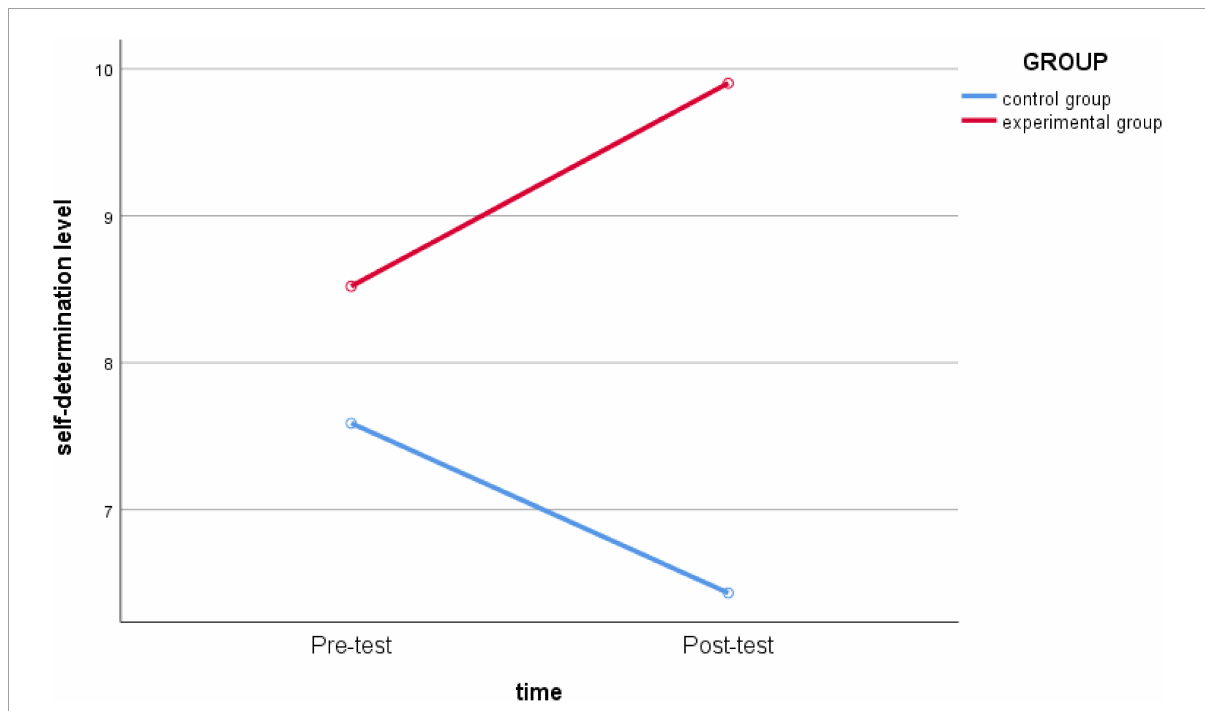
FIGURE1 Schematic diagram of the changes in self-determination level between the experimental group and the control group before and after intervention.